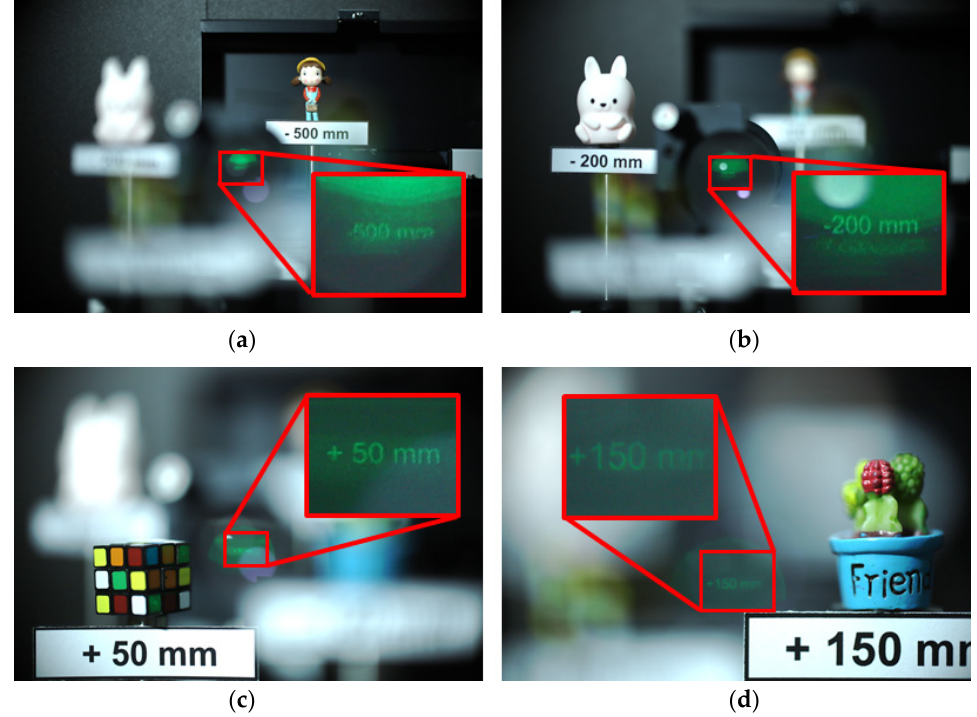
Figure 13. Reconstruction image using the LED light source with a spatial filter size 270 µm. The captured images focused at ( a ) –500, ( b ) –200, ( c ) +50, and ( d ) +150 mm from the hologram plane.